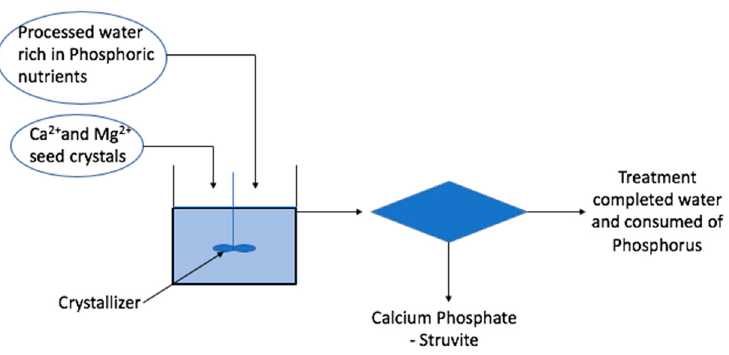
Figure 5. Schematic diagram for recovery of nitrogen and phosphorus in liquid phase from wastewater.